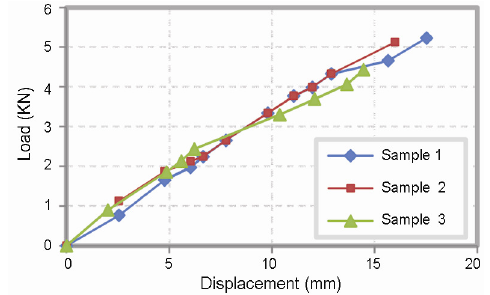
Fig. 7. Load-displacement curves for different specimens without strengthening